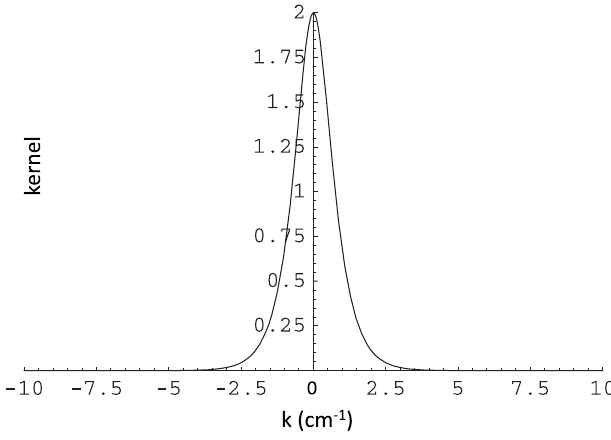
ð kR Þ as a function of k for the m